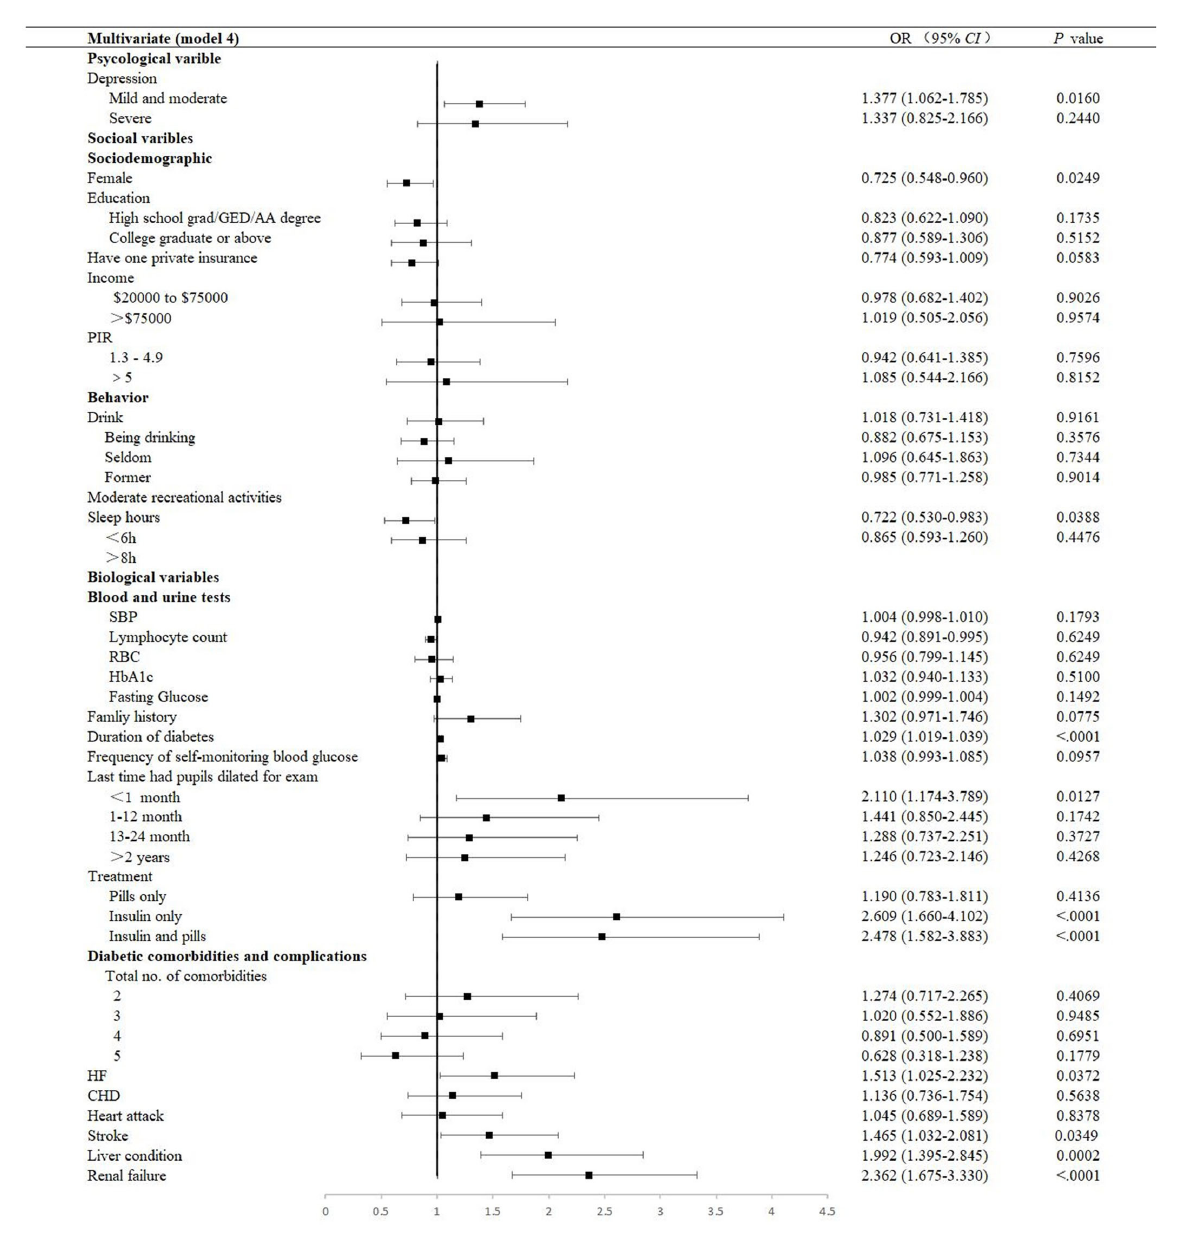
FIGURE3 Multivariate forest plot of the association between factors and DR (Model 4). Model 4 was performed by adjusting all covariables, including sociodemographic variables, diabetic-related clinical variables, diabetic comorbidities, behavioral variables, and sociodemographic variables. DR, diabetic retinopathy; OR, odds ratios; CI, confidence interval; GED, General Educational Development; AA, Associate of Arts; PIR, Ratio of family income to the poverty level. PIR was calculated by dividing the family income by the poverty guidelines specific to the survey year; the respondent only reported income as < $20,000 or ≥ $20,000, and the value was not computed; SBP, systolic blood pressure; RBC, red blood cell; HbA1c, glycosylated hemoglobin; HF, heart failure; CHD, coronary heart